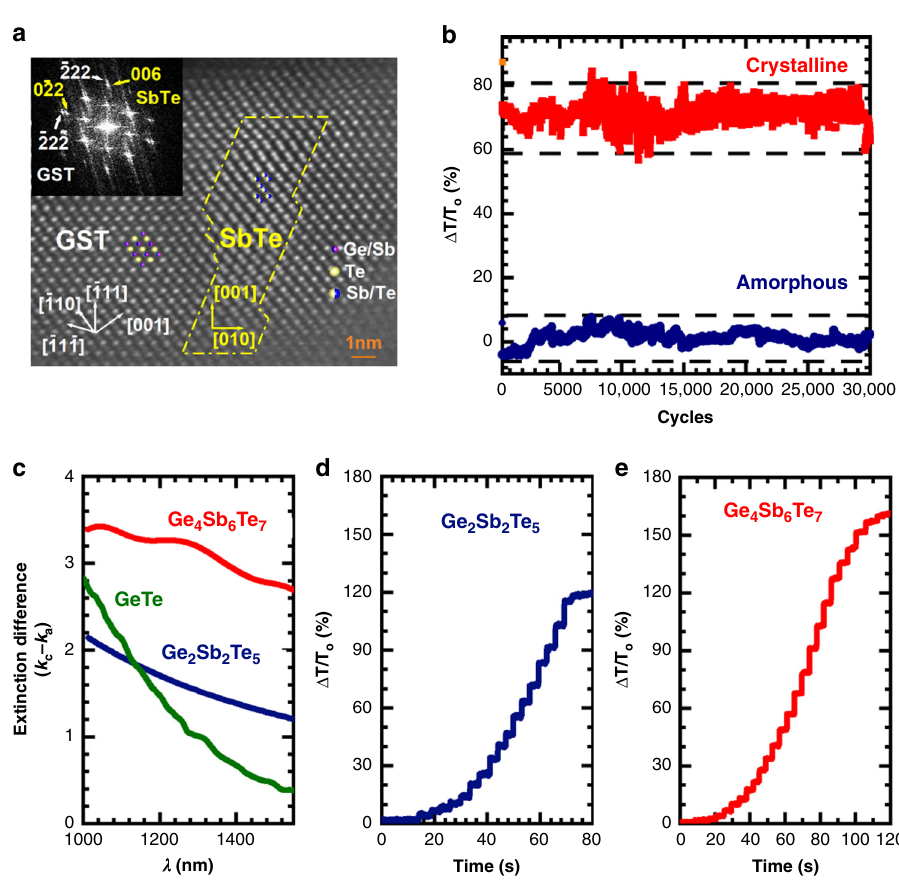
Fig. 4 Nanostructure and device performance of (Ge 4 Sb 6 Te 7 ) GST467. Newly identi fi ed phase-change memory material GST467 shows large optical contrast ideal for photonic-switching device applications such as neuromorphic computing. a High resolution transmission electron microscopy image reveals formation of coherent nanocomposite of GST structure matrix and SbTe. The dotted lines denote the atomically sharp interface. The FFT (inset) of this region indicates structural similarity of the adjacent phases; b endurance of the GST467: it is stable over 30,000 cycles indicating the robustness of the nanocomposite structure de fi ned by local composition variation. The dotted lines indicate the range of each state in relative optical transmission Δ T / T o at 1500 nm. Laser pulses were 50 ns with 183 pJ for quenching and 500 ns with 3.3 nJ for crystallization. The fl uctuations in Δ T / T o are due to the thermal fl uctuation of the device measurement set-up; c comparison of the optical contrast here indicated by difference in the extinction coef fi cient k between crystalline and amorphous phases ( k c − k a ) for the wavelength range of 1000 – 1500 nm for various compositions within Ge – Sb – Te system. GST225 and GST467 data are from this work. The GeTe data are from ref. 55 . GST467 shows higher extinction difference over other known compositions; one-to-one comparison of d GST225 (left) and e GST467 (right) for multi-level switching in optical transmission at 1500 nm ( Δ T / T o ) using 500 ns, 6 pJ